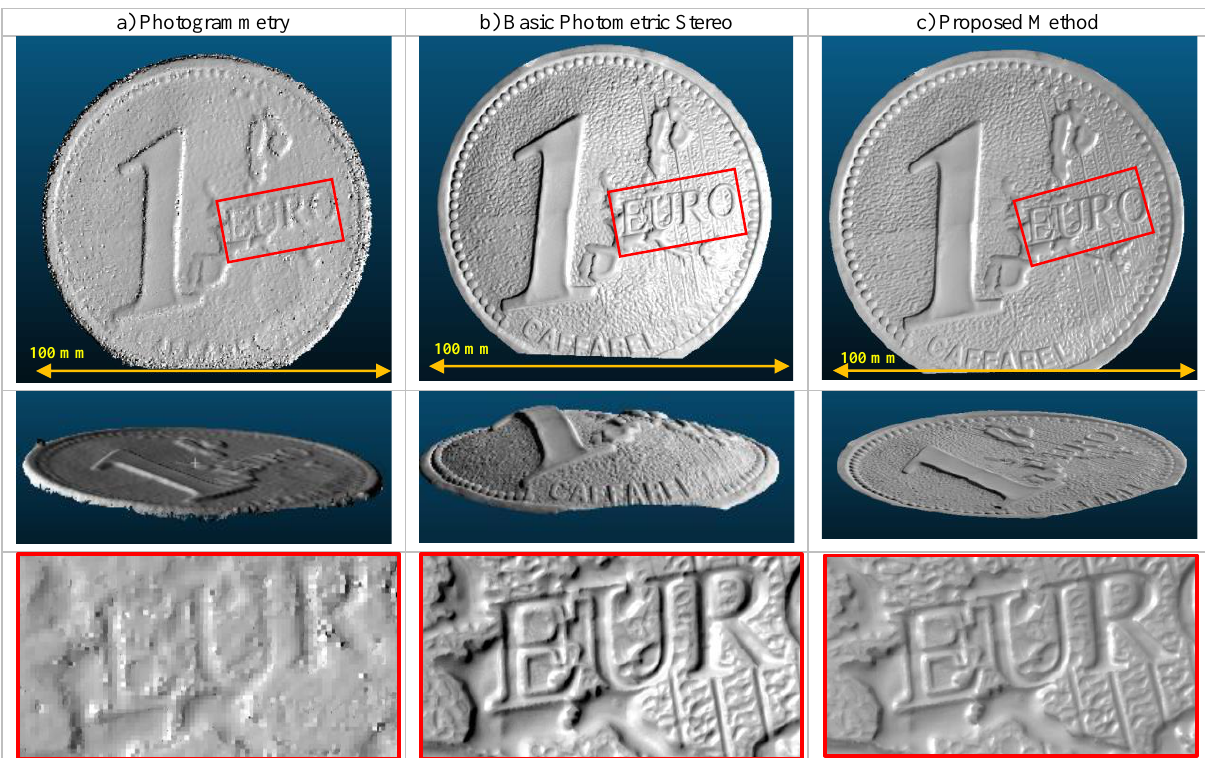
Figure 5. 3D reconstruction of the shiny surface shaped like a Euro coin. Accurate low-frequency information but noisy 3D details derived with photogrammetry (a). High-details but deformed global shape derived with photometric stereo (b). Reduced distortion with high-details produced with the integrated solution